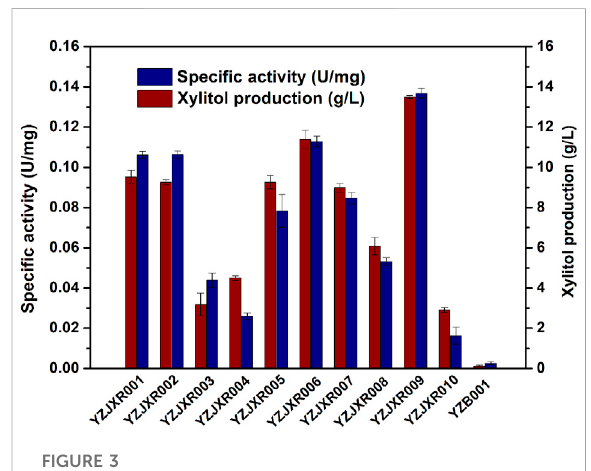
FIGURE 3 Comparison of XR activities of strains with different